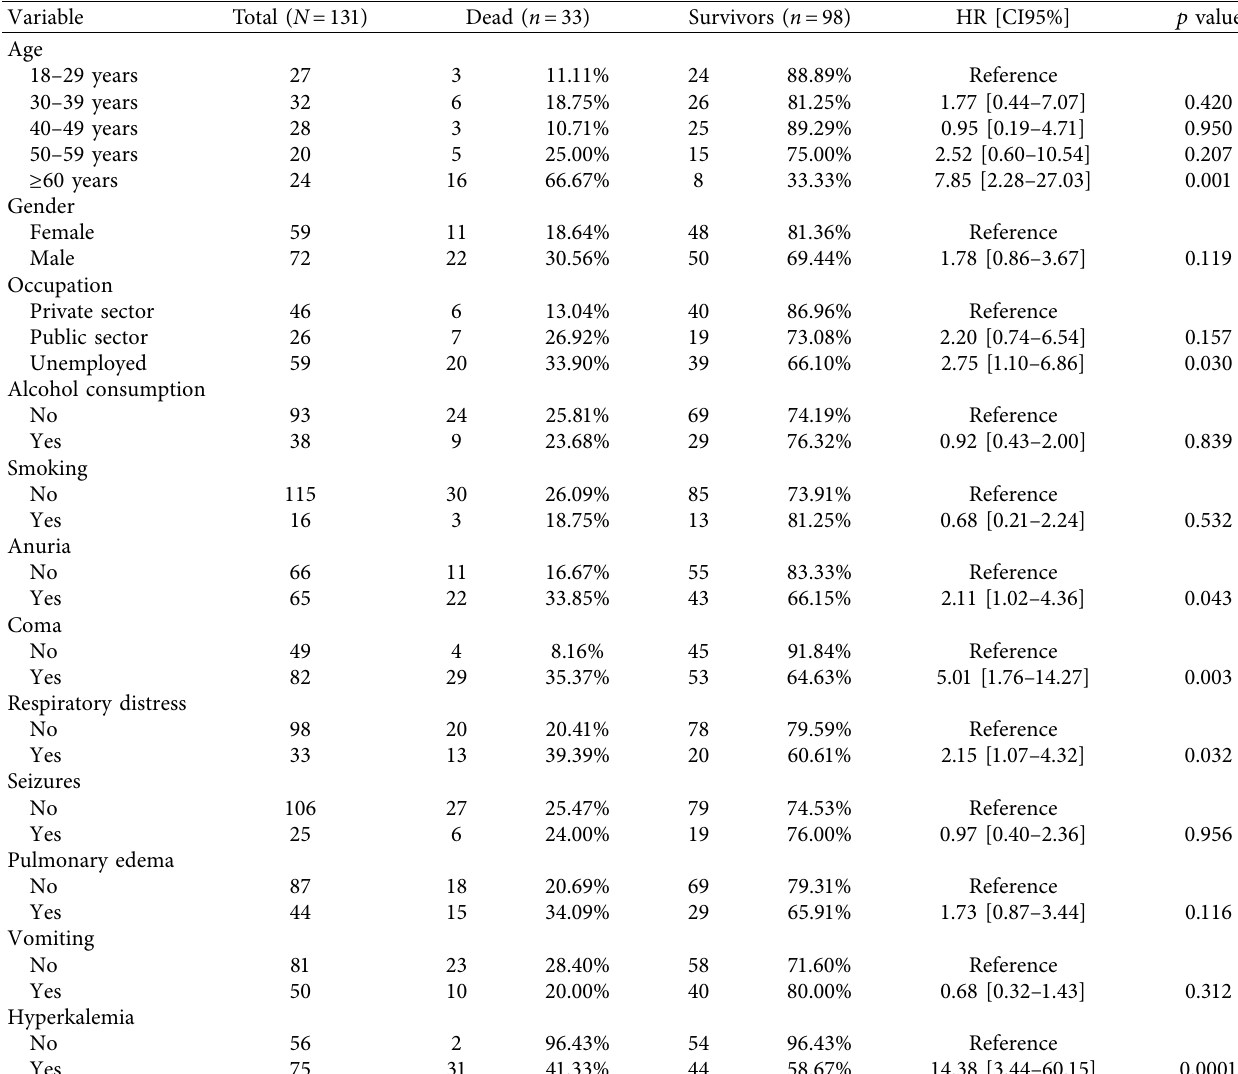
Table 1: Demographic and clinical characteristics of AKI stage 3 Congolese adults admitted to the CIMAK hemodialysis centre in North- Kivu province in the